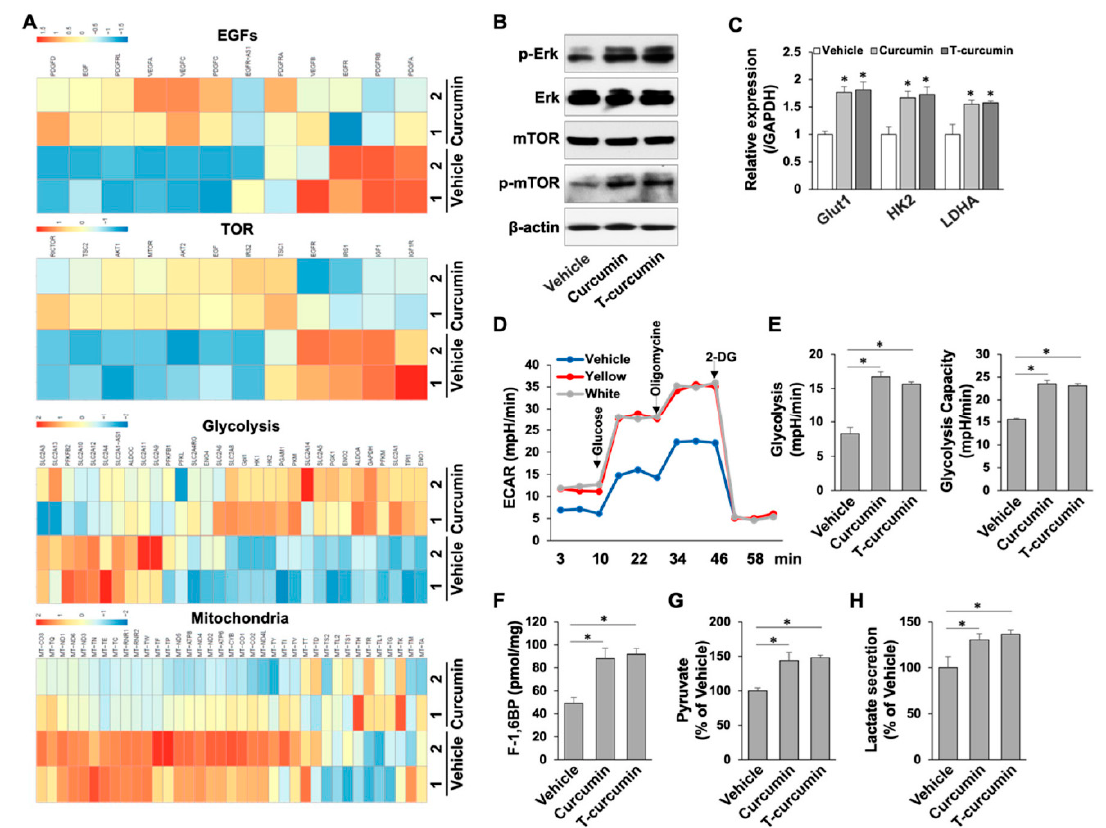
Figure 4. Curcumin reprogramed energy metabolism toward glycolysis through growth factor path- ways and their downstream ERK and mTOR cascades. ( A ) Heat map of RNA-seq transcriptomic data showing the growth factor genes and Akt-mTOR cascades were differentially regulated by curcumin treatment in PDLSCs. In addition, energy metabolism was re-configurated toward glycol- ysis after curcumin treatment. ( B ) Western blot analysis showed the expression levels of p-ERK, ERK, mTOR, and p-mTOR in PDLSCs with or without curcumin treatment. ( C ) qPCR analysis con- firmed that glycolytic genes, Glut1, HK2, and LDHA were significantly elevated after curcumin treatment in PDLSCs. ( D ) Seahorse assay results for ECAR of PDLSCs with or without curcumin treatment. ( E ) The contribution of associated parameters including glycolysis and glycolytic capac- ity to the total ECAR was plotted. ( F ) Intracellular concentrations of fructose-1,6-bisphosphate in PDLSCs with or without curcumin treatment. ( G , H ) Curcumin treated PDLSCs had increased gly- colytic intermediates pyruvate ( G ) and lactate ( H ). * p < 0.005. Error bars represent the s.d. from the mean values.